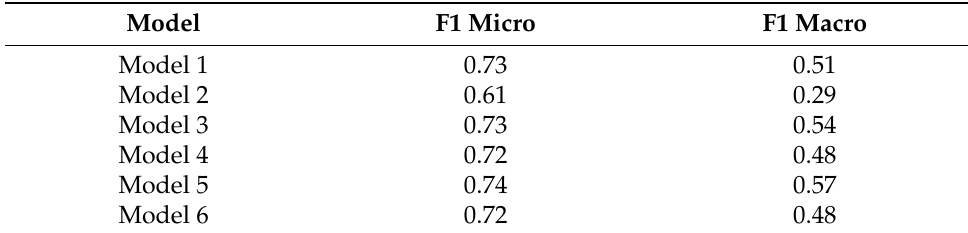
Table 21. F1 scores for the 6 best models.